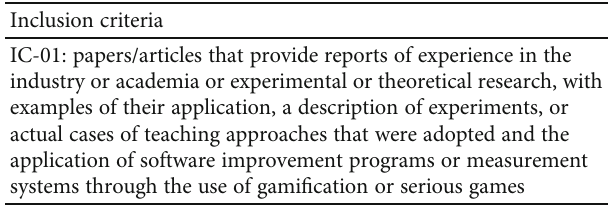
Table 2: Inclusion criteria.